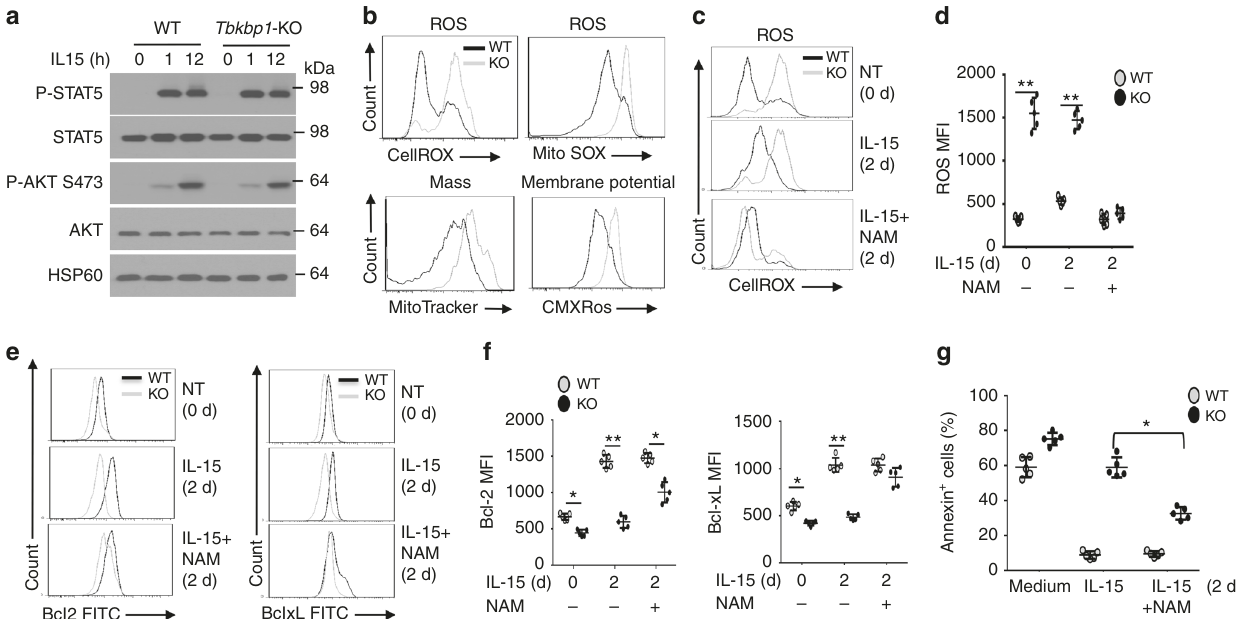
Fig. 5 Tbkbp1-mediated NKT cell survival involves regulation of mitochondria ROS. a IB analyses of the indicated phosphorylated (P-) and total proteins of NKT cells stimulated with IL-15 for the indicated time periods. b Flow cytometric analysis of WT and Tbkbp1 -KO thymic NKT cells that were stained with CellROX TM Deep Red and MitoSOX for detection of ROS or stained with MitoTracker Green and MitoTracker Red CMXRos for detection of mitochondrial mass and membrane potential, respectively. c , d Flow cytometric analysis of ROS concentration in WT and Tbkbp1 -KO thymic NKT cells that either untreated (0 h) or cultured for 2 days with IL-15 or IL-15 plus NAM. Data are presented as a representative plot ( c ) and summary graph ( d ). n = 5 per genotype group. e , f Flow cytometric analysis of intracellular Bcl-2 or Bcl-xL level in WT and Tbkbp1 -KO thymic NKT cells that either untreated (0 h) or cultured for 2 days with IL-15 or IL-15 plus NAM. Data are presented as representative plots ( e ) and summary graphs ( f ). n = 5 mice per genotype group. g Flow cytometry quanti fi cation of AnnexinV + apoptotic cells in thymic NKT cells cultured for 2 days with medium control, IL-15, or IL-15 plus NAM, presented as a summary graph. n = 5 mice per genotype group. Data are representative of three independent experiments, and bar graphs are presented